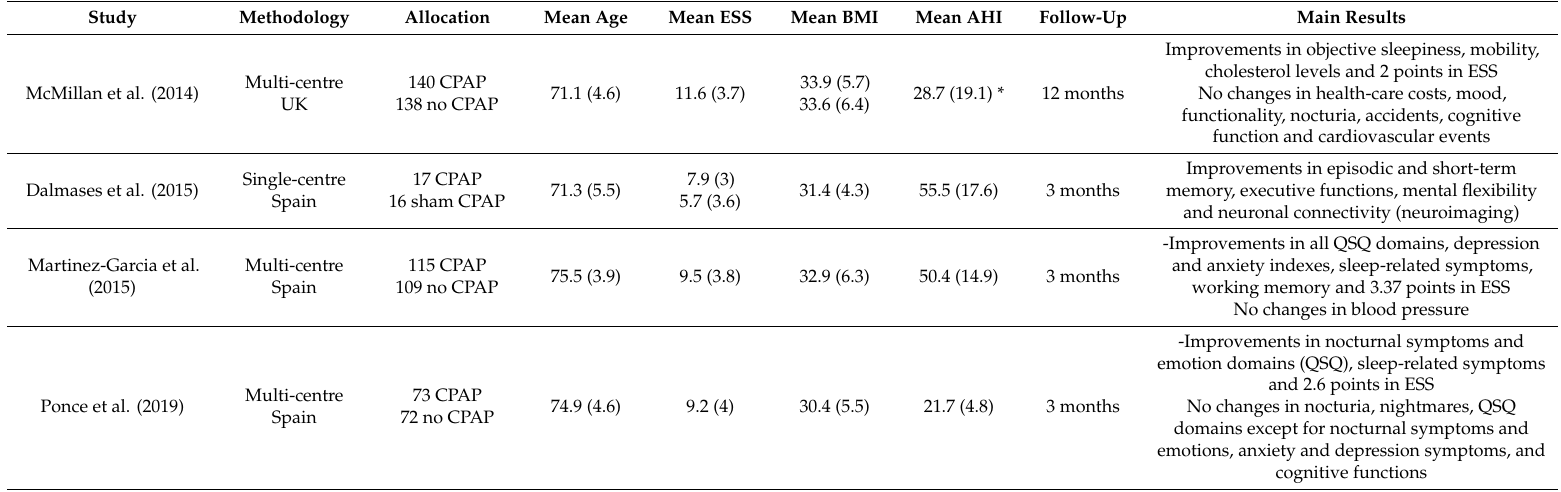
Table 2. Characteristics and main results of the clinical trials undertaken on the e ff ect of continuous positive airway pressure (CPAP) treatment in clinical series consisting exclusively of elderly patients (aged at least 65